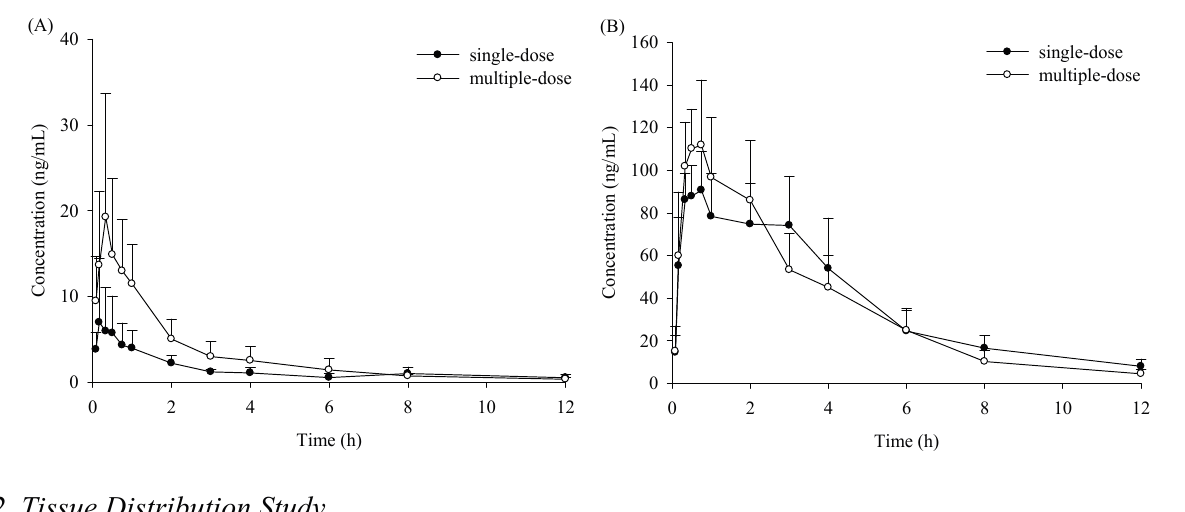
Figure 4. Time-concentration profiles of verticinone after single and multiple-oral dose of 2 mg/kg administration to rats: ( A ) female; ( B )